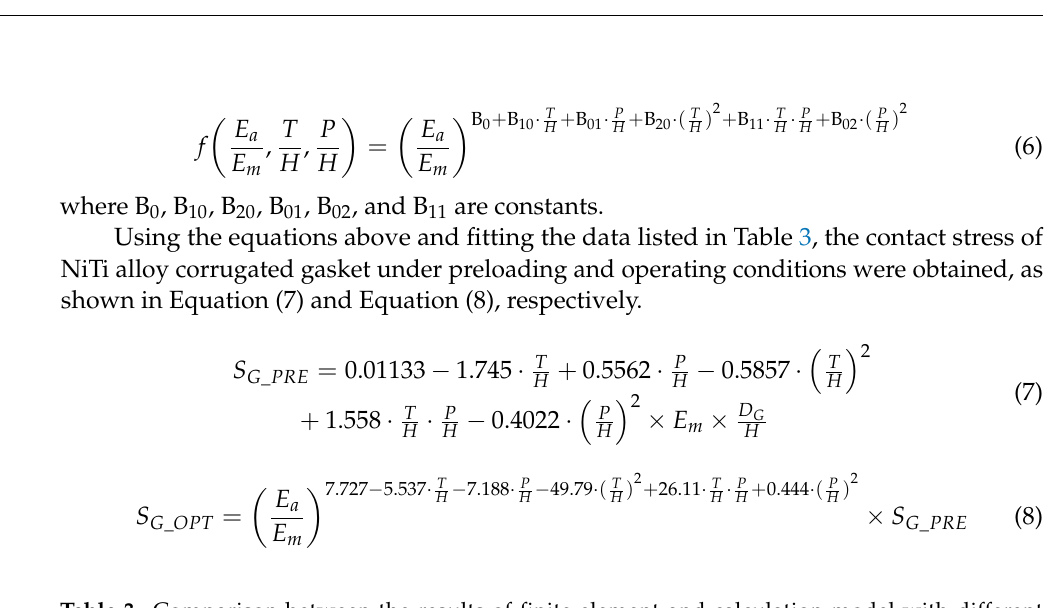
Table 3. Comparison between the results of finite element and calculation model with different structural